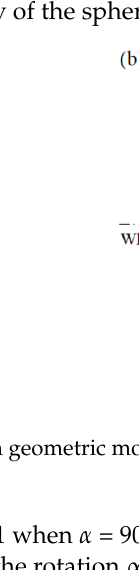
Figure 3. Schematic diagram of the torus.